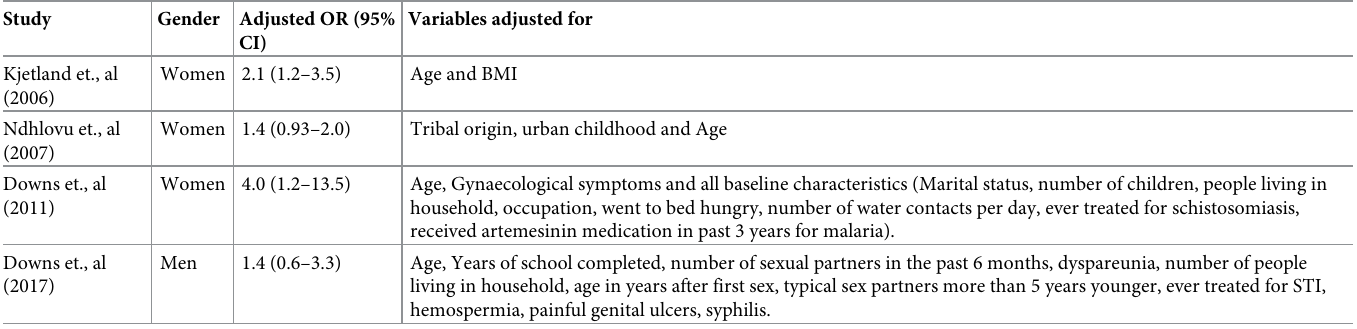
Table 3. Summary of the shortlisted papers that reported an adjusted OR.